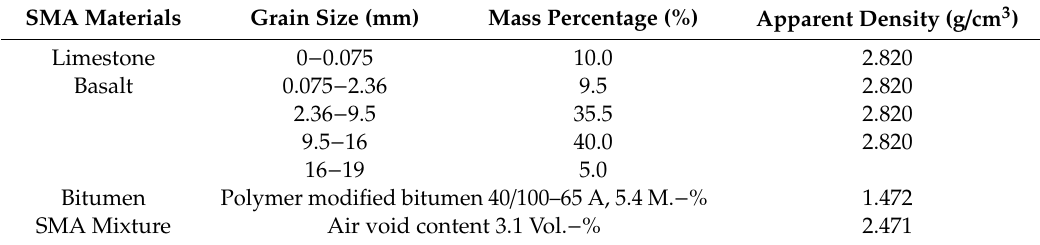
Table 3. Mix design of SMA mixture.